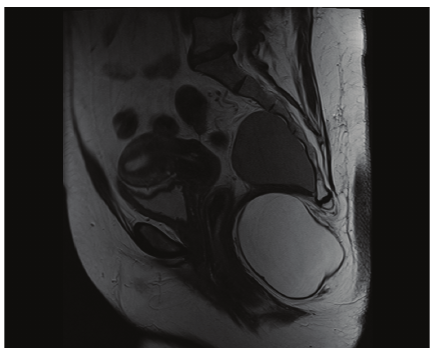
Figure 1: Sagital T 2 -weighted MR image demonstrating a bilobed, well-defined cystic lesion in the presacral, precoccygeal and infra- coccygeal